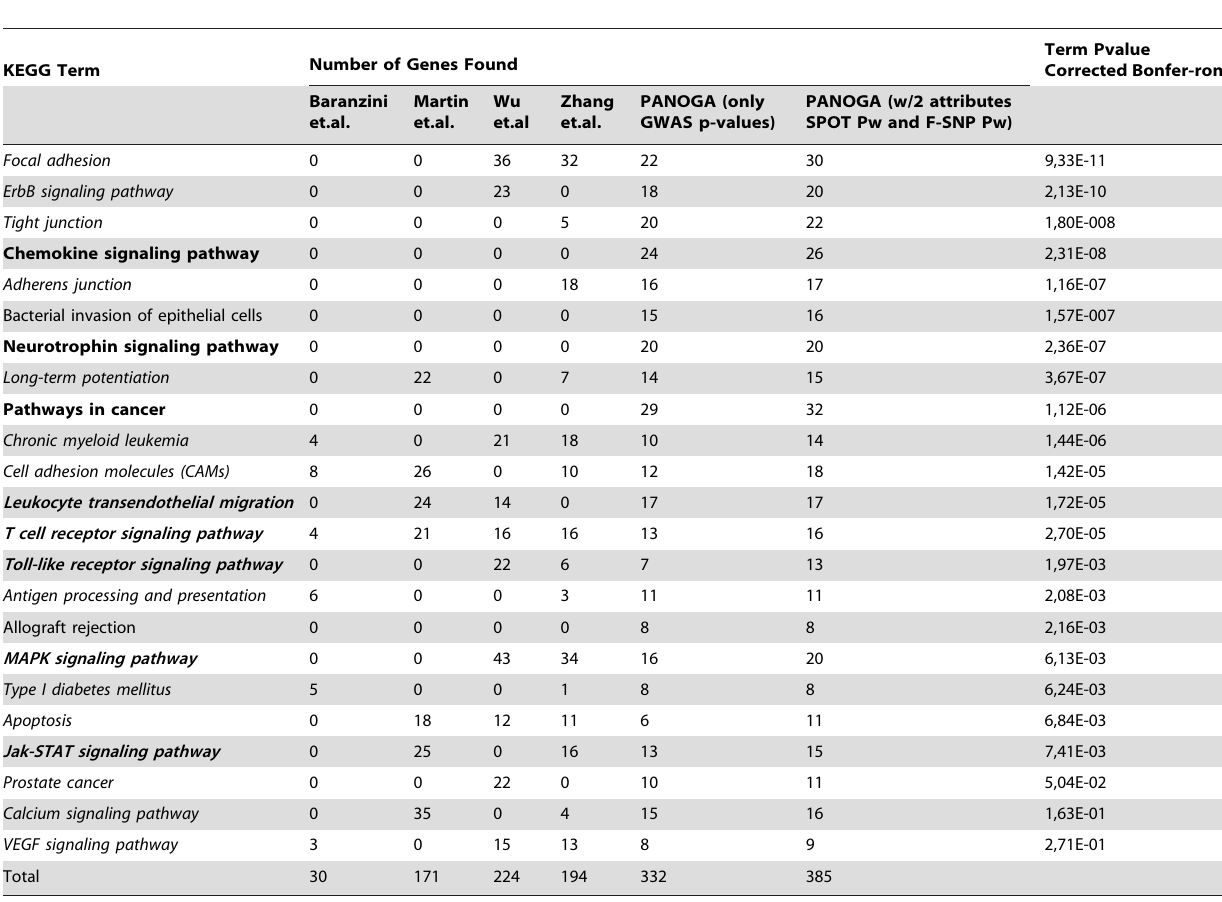
Table 3. Comparison of found KEGG pathways with previous studies in terms of number of genes associated within each KEGG